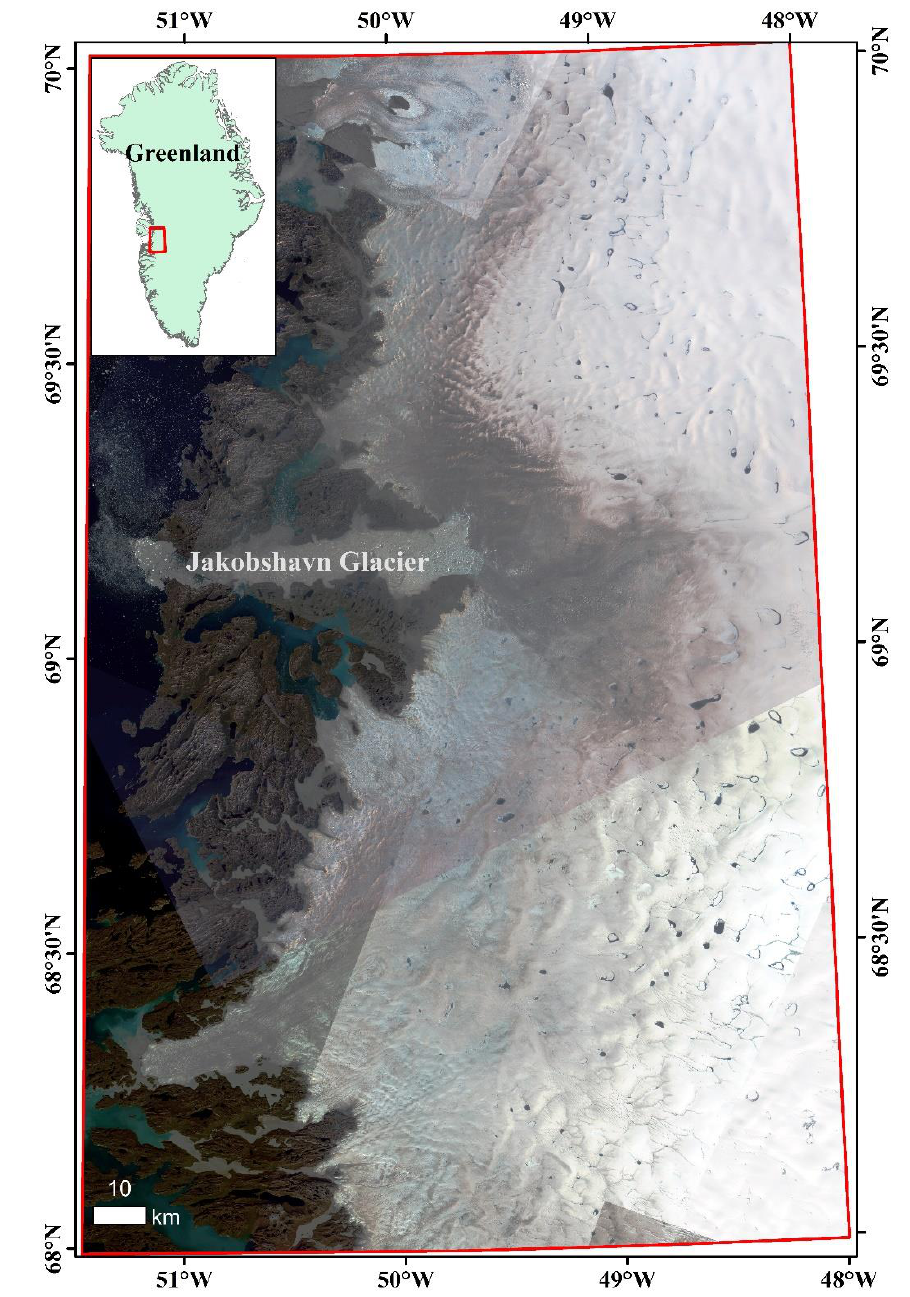
Figure 1. The geographic location of the study region in Greenland. The background image is a Landsat 8 30-m true-color average performance image of the melt season of 2018.